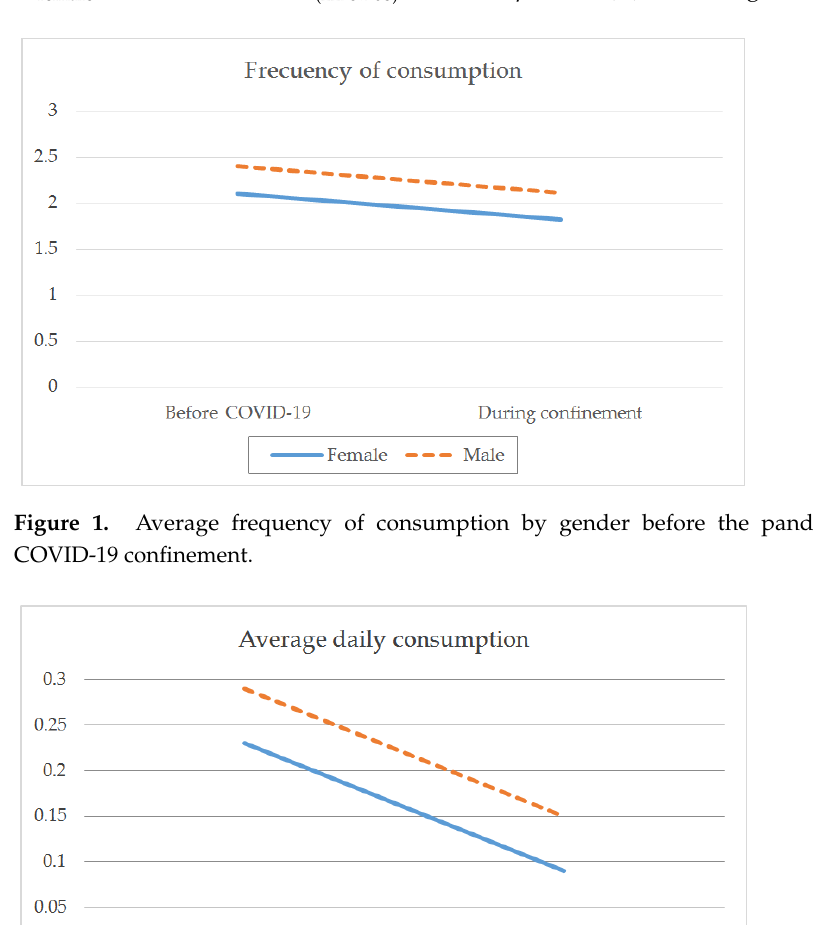
Table 2. Alcohol consumption patterns before and during confinement as a function of gender.